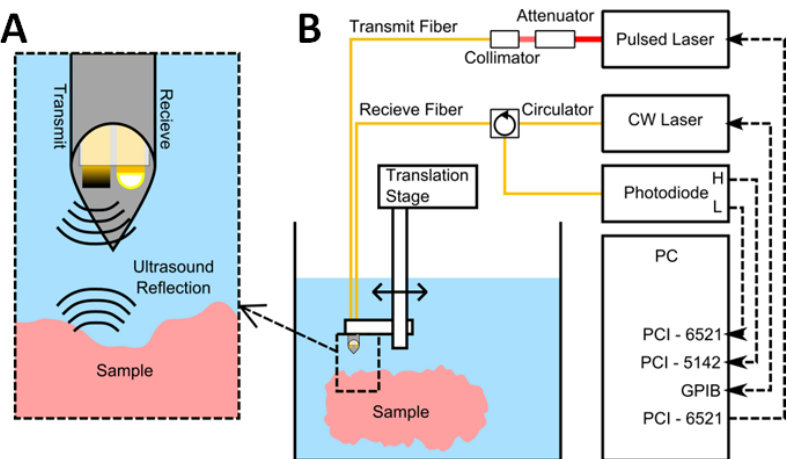
Figure 7. ( A ) The fiber-optic all-optical ultrasound transducer (AOUST) consisting of an optical fiber with a CNTs–PDMS nanocomposite coating for LGUS transmission and an adjacent fiber with an Fabry-Perot (FP) etalon for optical detection of ultrasound (ODUS) sensing. Tubular metal housing is also shown. (B) The imaging system for the AOUST probe. CW: continuous wave; GPIB: general